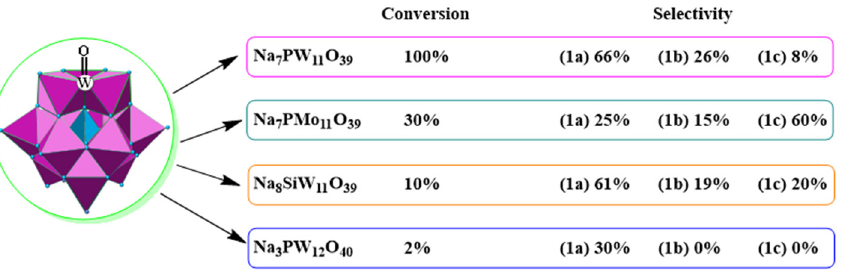
Figure 13. Impact of heteropolyanion on the efficiency of Keggin HPA sodium salts (adapted from ref. [30]).